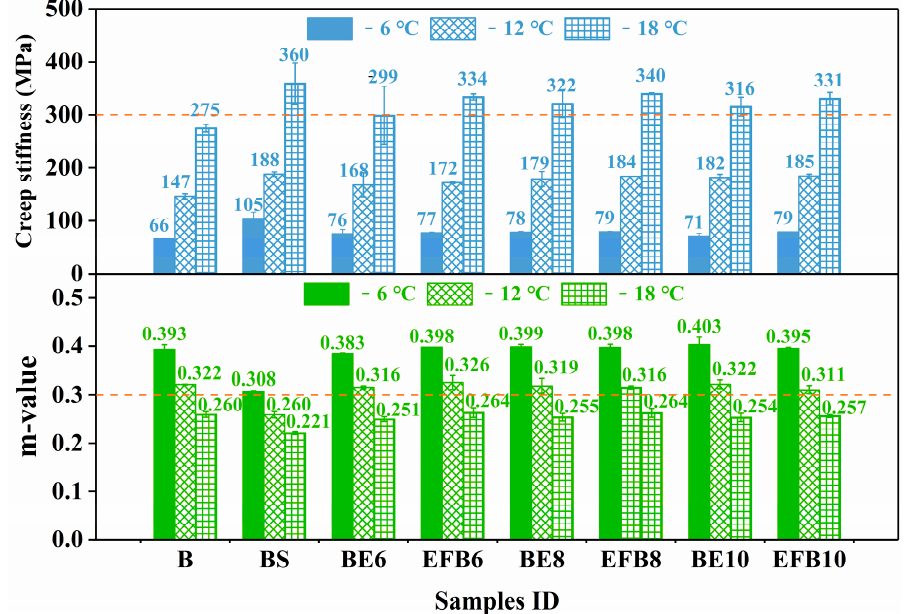
Figure 8. BBR test results: Creep stiffness and m-value of all binders at different temperatures.